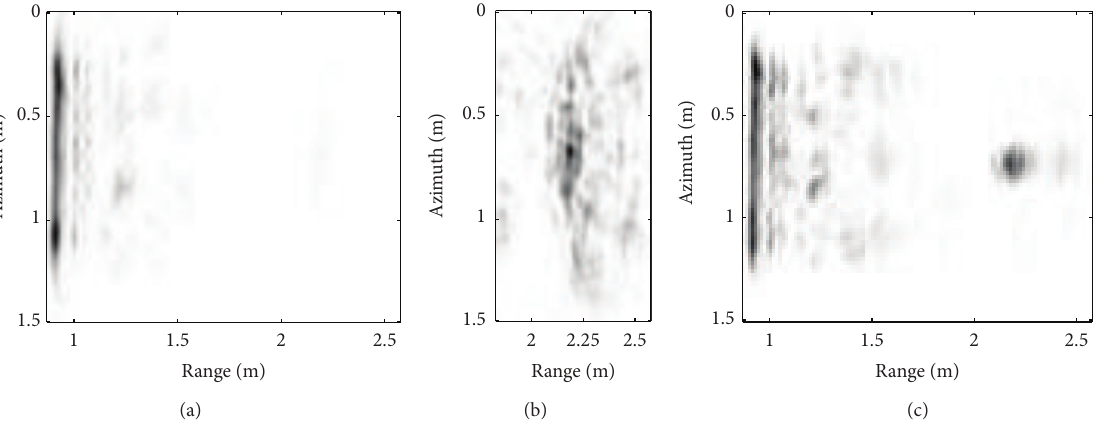
Figure 11: (a) A range-compressed SAR image. The wall is clearly seen. (b) The energy of the corner reflector is spread in azimuth at approximate range 2.25 m. (c) A fully processed SAR image where the presence of a corner reflector is clearly spotted at range 2.25 m.